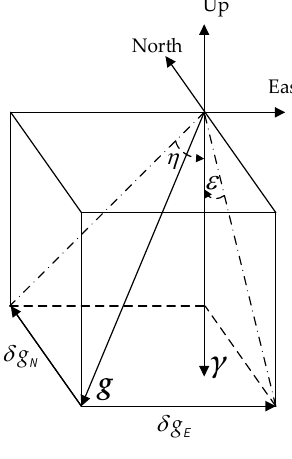
Figure 3. The definition of gravity disturbance vector, gravity disturbance and deflection of vertical.